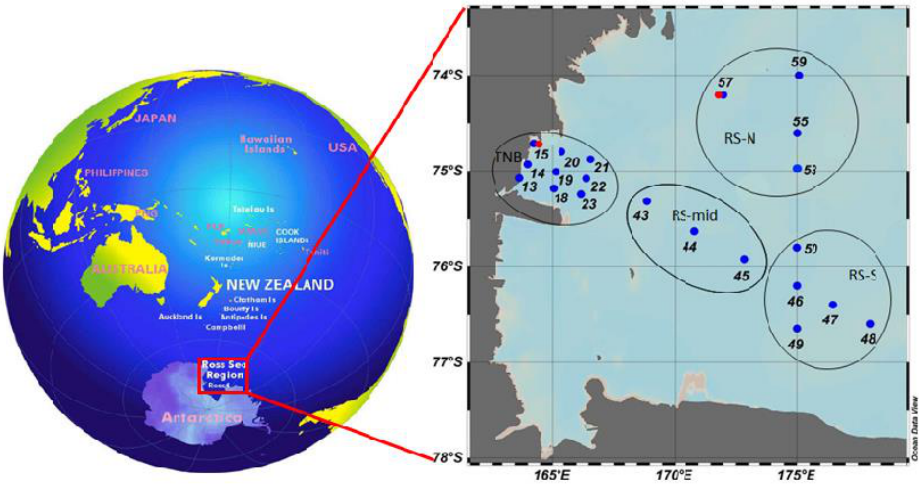
Figure 1. Study area in the Ross Sea (RS) and sampling stations. The macro-areas of Terra Nova Bay and RS o ff shore area were represented (in blue the sampling stations, in red the repeated